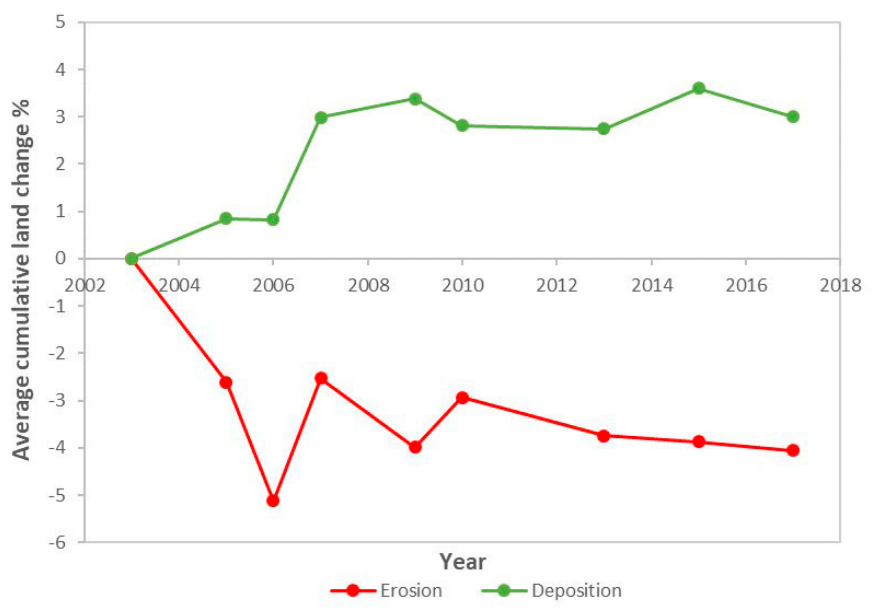
Figure 7. Average cumulative marsh terraces land change from all the sites by year.